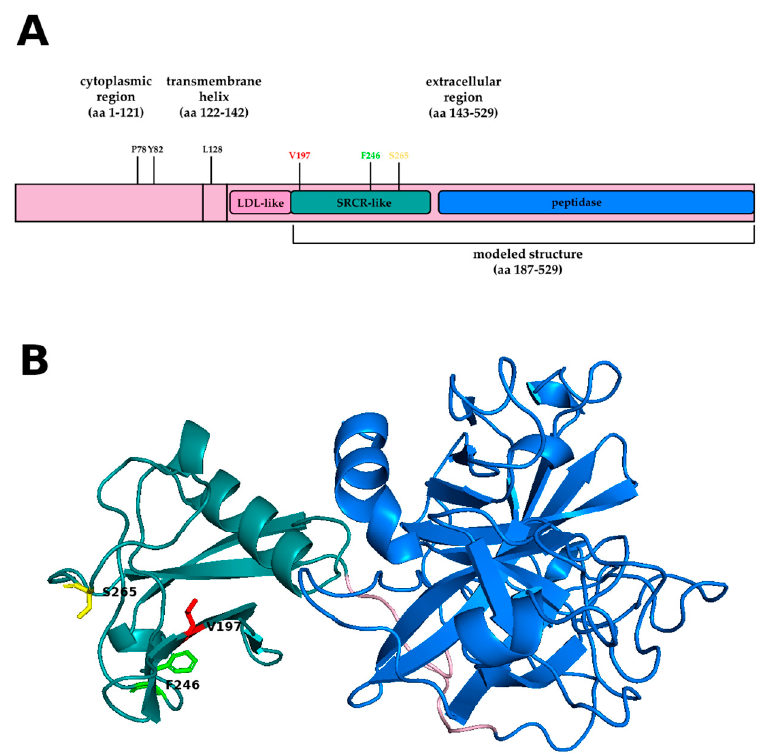
Figure 2. TMPRSS2 structure. A linear representation of TMPRSS2 is shown in panel ( A ). The probably and possibly damaging mutations identified by the HumVar-trained model in wAnnovar are highlighted. The model of the region spanning from aa 187 to 526 is shown as a cartoon in panel ( B ). The SRCR-like domain is in deep teal cyan, peptidase domain is in marine blue, and the linker is in light pink. V197 (red), F246 (green), and S265 (yellow) belong to the SRCR-like domain. On the other side, the synonymous variant p.G296G, which corresponds to NM_001135099: exon9:c.C888T, is not annotated as an eQTL and does not fall at the exon-intron